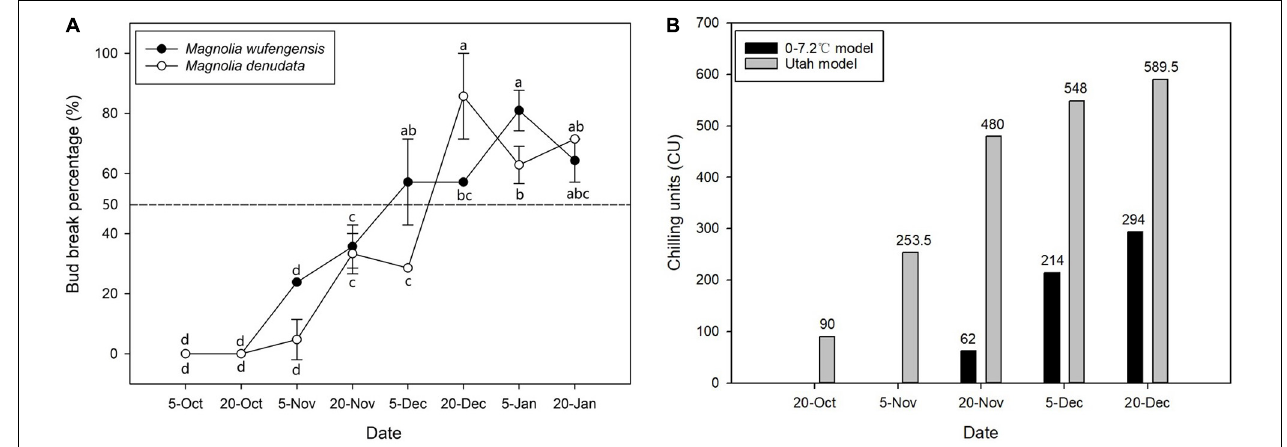
FIGURE 1 | Bud break percentage and chilling units of Magnolia wufengensis and Magnolia denudata during 2020–2021 dormancy phase under natural conditions. (A) Bud break percentage of Magnolia wufengensis and Magnolia denudata was assessed after 32 days in 2020–2021. (B) Chilling units were calculated based on 0–7.2 ◦ C and Utah models beginning on 14 November and 29 September 2020, respectively. Each experiment was performed with three biological replicates. Different letters above bars indicate a significant difference among bud break percentage according to ANOVA and LSD test ( p < 0.05).